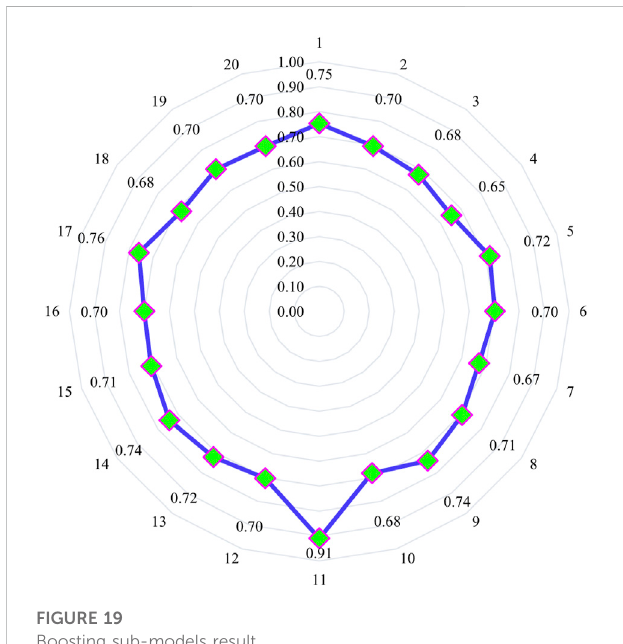
FIGURE 19 Boosting sub-models result.